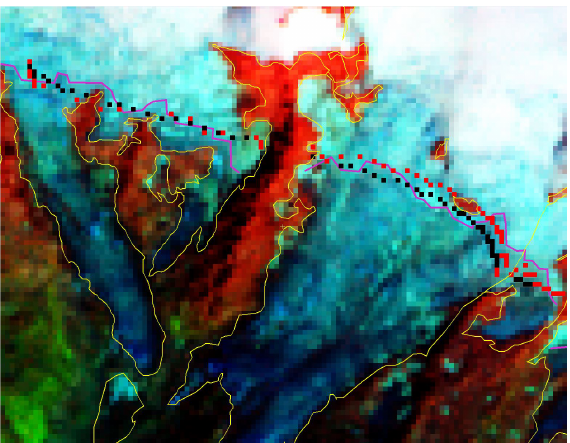
Figure 7. A representation on a Green/NIR/SWIR spectral band combination of the southern side of the Mont Rose area with the initialized snow line, with a 4-dimensional polynomial in black, the result of the active contour detection in red, and the 3 September 2019 ground truth snow line in